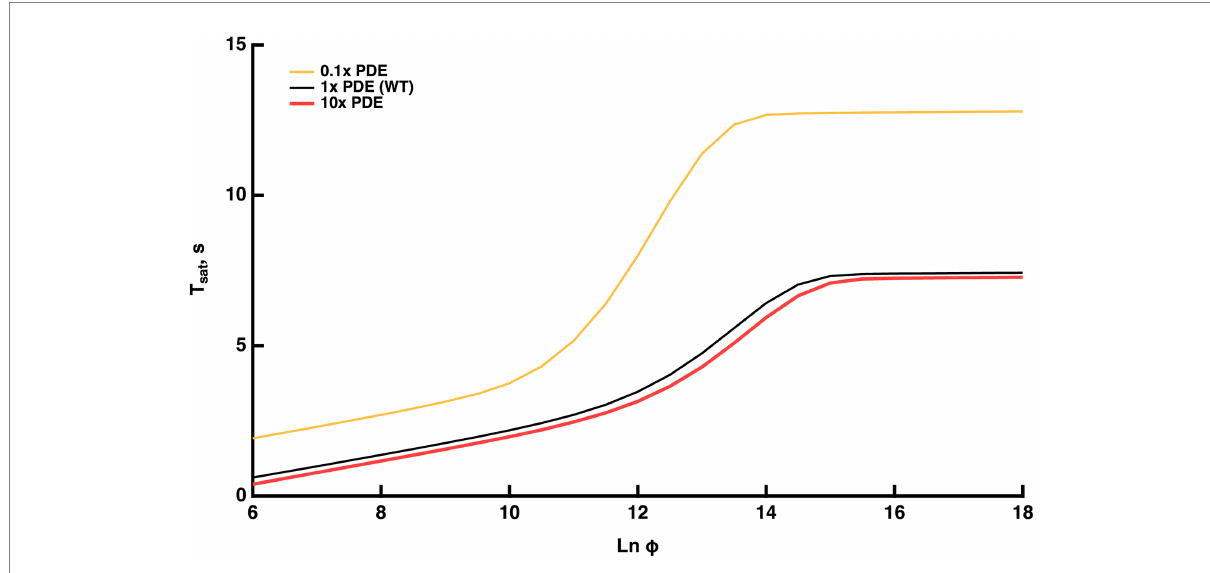
FIGURE 5 Model prediction that the Pepperberg relations will plateau with flash strengths that fully activate PDE. Predictions are also shown for theoretical variations in the level of PDE expression: 0.1x (10-fold lower level of PDE present than in WT), WT, 10x (10-fold higher level of PDE present than in WT).